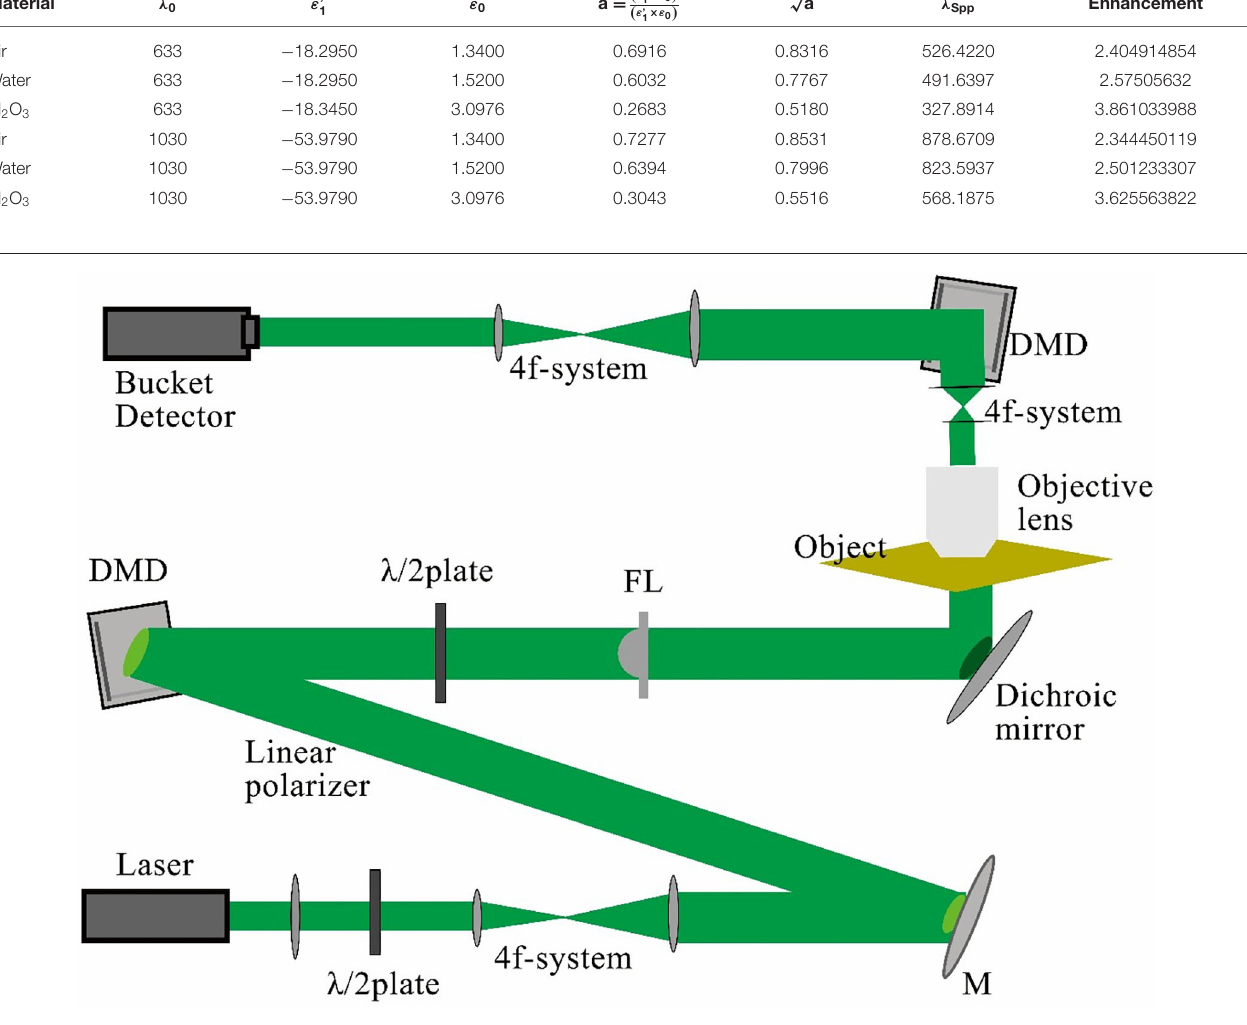
FIGURE 4 | Schematic of ghost imaging based on plasmonic structure illumination microscopy (PSIM-GI)